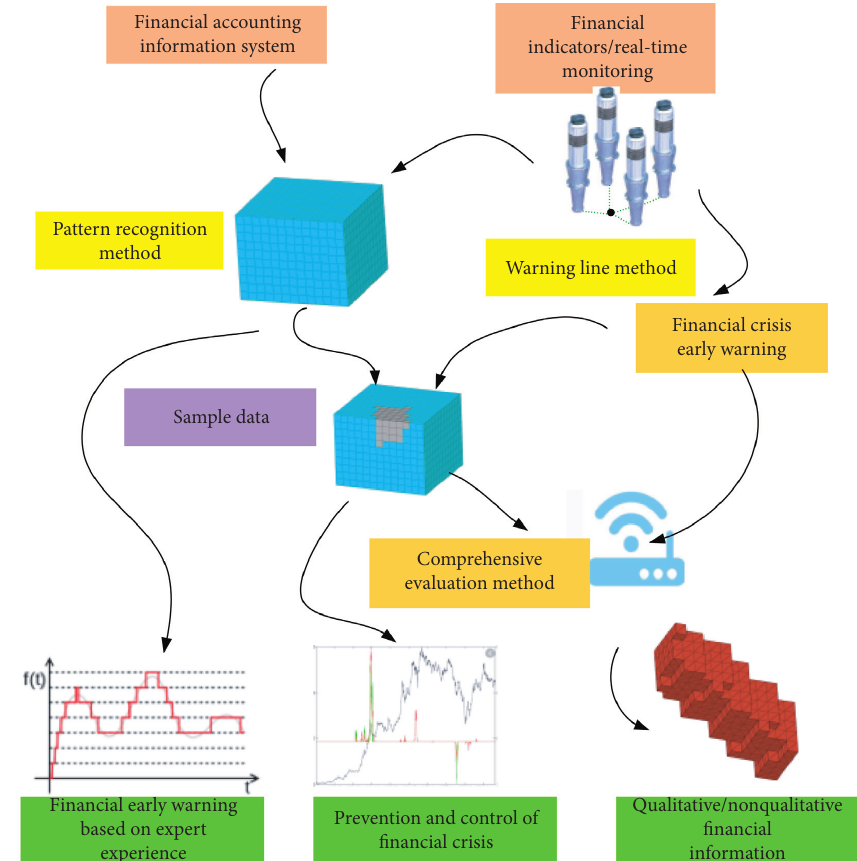
Figure 2: Panel discrete selection model.